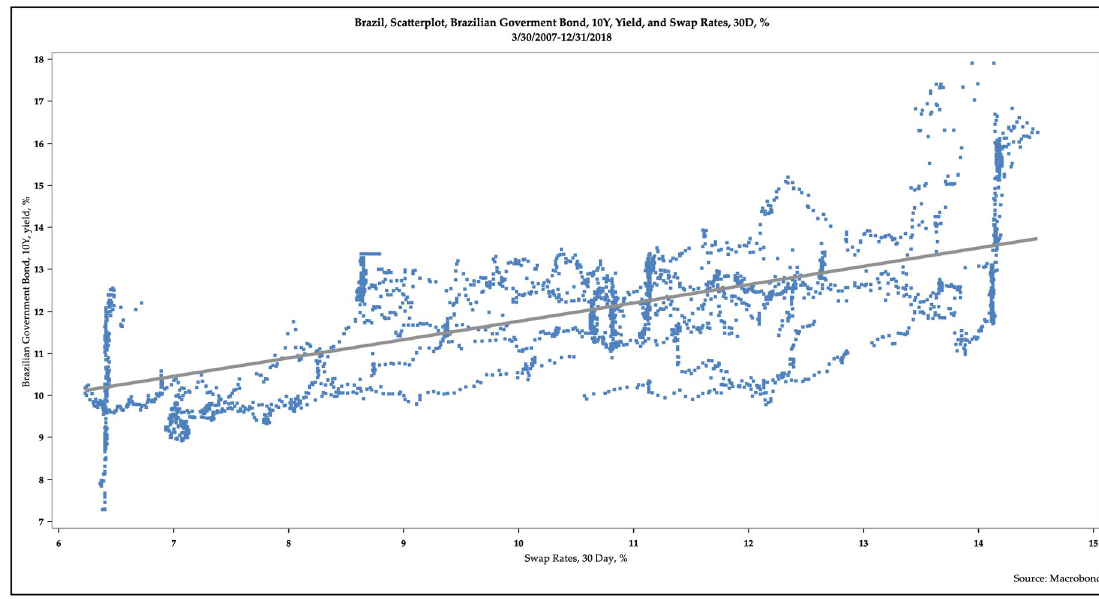
https://doi.org/10.1371/journal.pone.0257313.g007